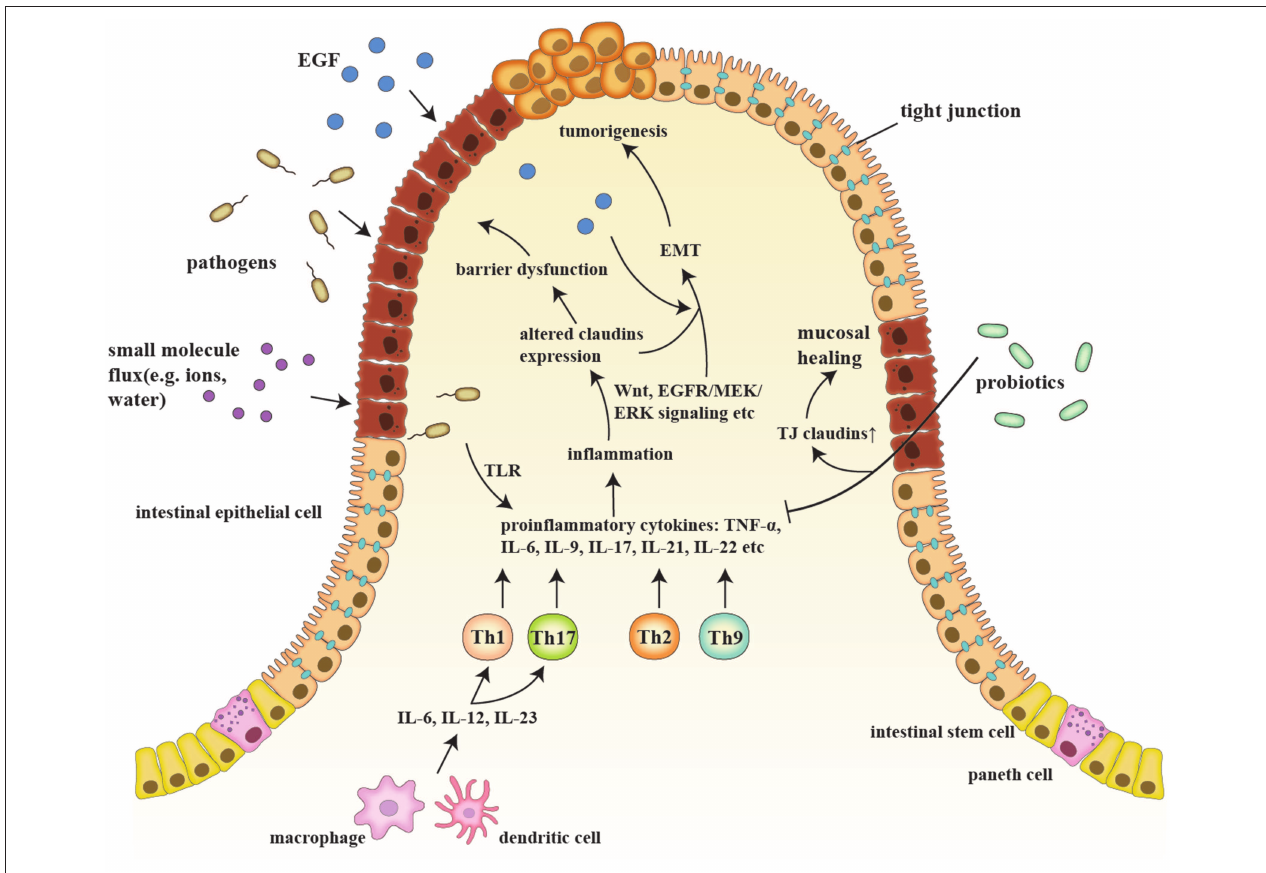
FIGURE 1 | A schematic model of claudins in the pathogenesis of IBD and consequent tumorigenesis. Etiologic factors, such as a pathogenic breach and dysbiosis, engender an overactive inflammatory response by secreting proinflammatory cytokines (e.g., IL-6, IL-9, and IL-23) and generating proinflammatory T cells (e.g., Th1, Th2, Th9, and Th17), which also changes claudin expression via multiple pathways, such as Wnt and MEK/ERK signaling. Claudin dysregulation directly leads to impaired barrier function and luminal bacterial leakage inversely exacerbates inflammation, while EGF influx contributes to tumorigenesis. EMT and tumorigenesis are results of sustained activation of signaling pathways that modulate cell growth and migration, in which claudins act as signaling proteins and modulate aggressive tumor behaviors. Probiotics, on the other hand, recover epithelial claudin expression, and therefore promote mucosal